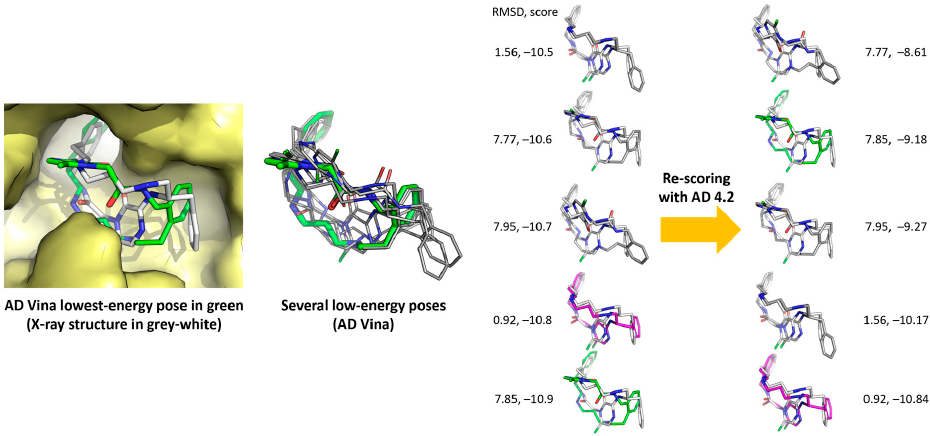
Figure 4. Re-scoring with AD 4.2 (right column) of AD Vina-predicted main poses of 3/1NM6 . Table 5. Re-scoring. AD 4.2//Vina results.